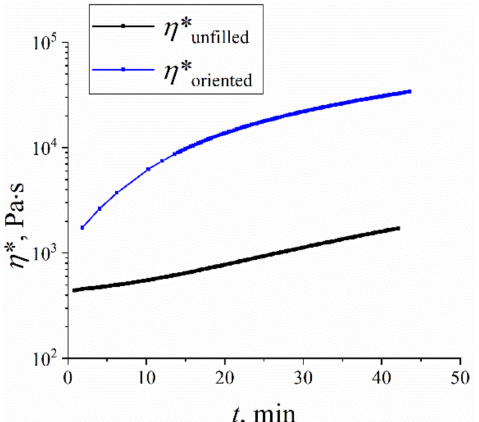
Figure 3. Experimental time dependence of the complex viscosity of unfilled R-BAPB ( η ∗ unfilled ) and R-BAPB filled by 0.1% of SWCNT ( η ∗ oriented ) at temperature 633 K. The error bars are equal to the instrumental